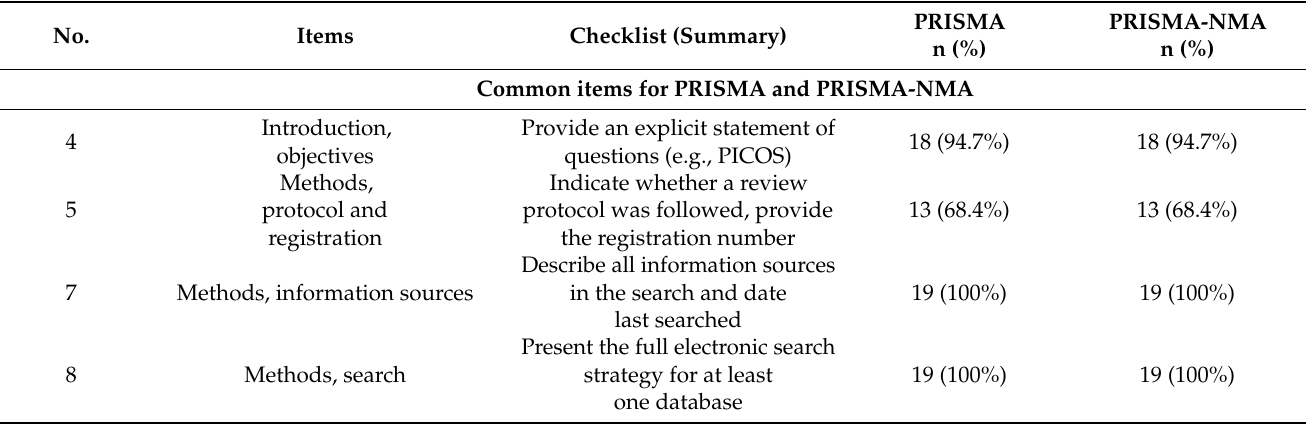
Table 3. Comparison of the positive results obtained by NMAs using the PRISMA and PRISMA-NMA